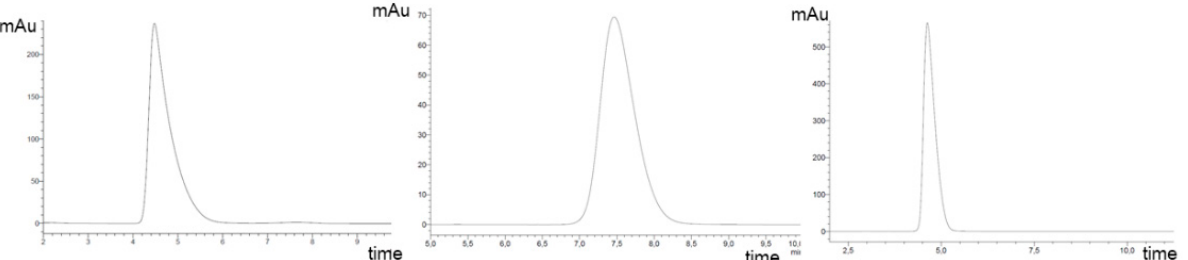
Figure 2. The representative chromatograms of compounds 1, 5, and 15.